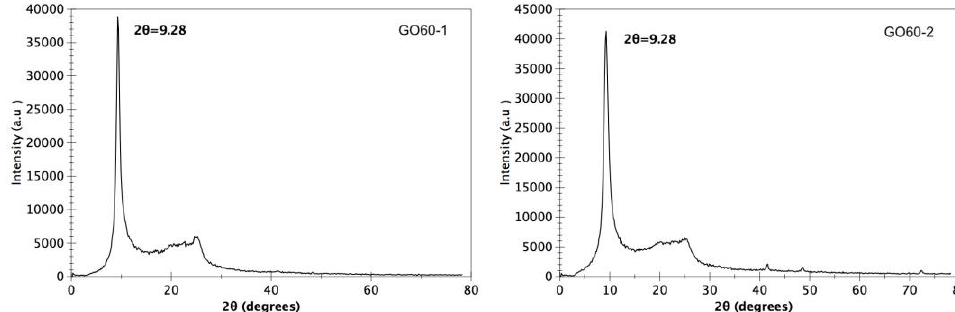
Figure 3. XRD pattern of graphene oxide dried at 60 °C.